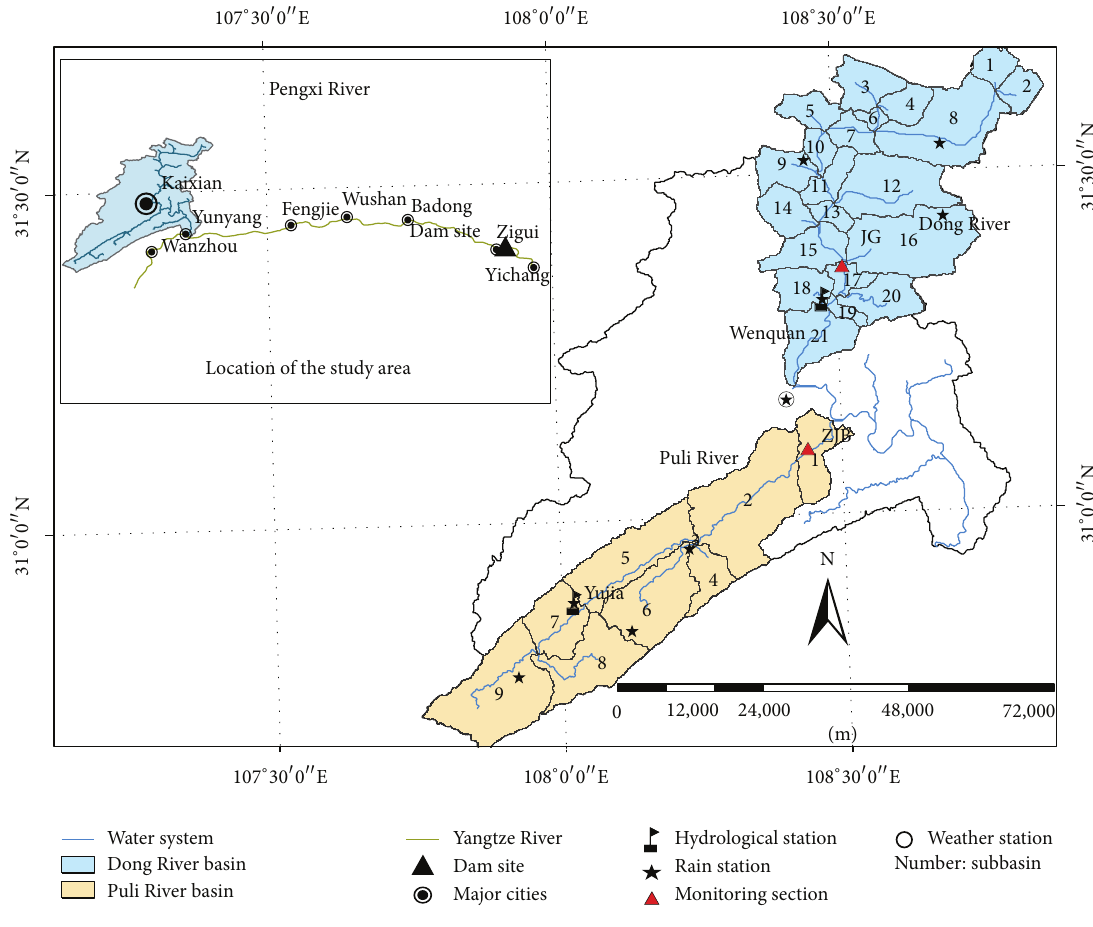
Figure 1: Location of the study